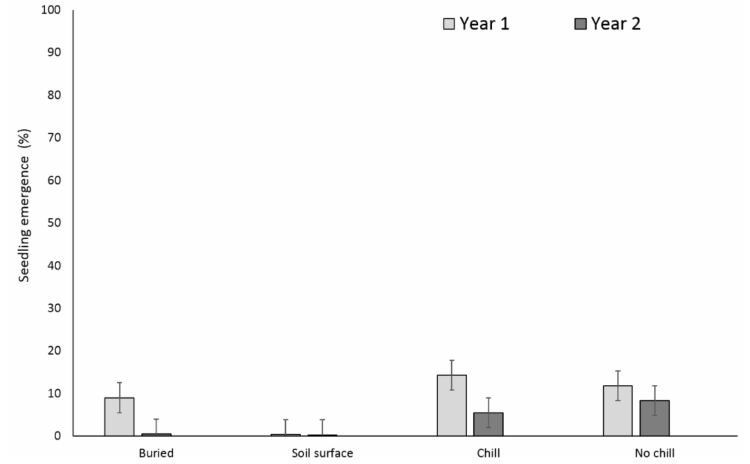
Figure 5. Effect of environmental conditions on X. strumarium emergence originating from a multiple maternal source. Vertical bars represent LSD at 5% significance level.